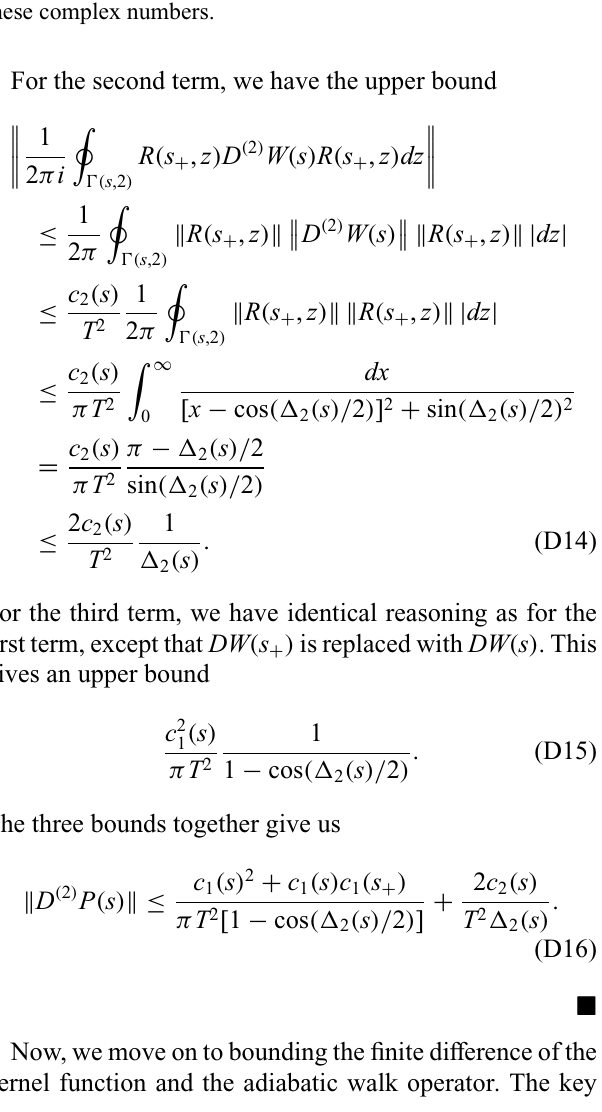
FIG. 8. The contour (cid:11)( s , 1, a ) that passes through the two gaps and has a closure of the contour via an arc at radius a + 1. The centers of the two gaps are denoted g 1,1 ( s ) and g 2,1 ( s ) and the contour is taken to have two straight lines that are multiples of these complex